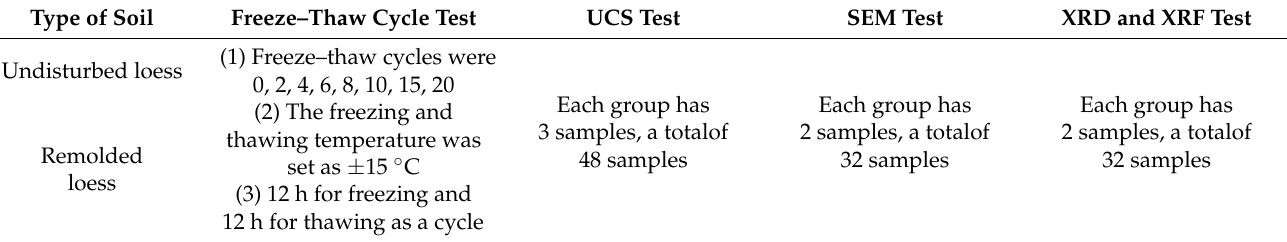
Table 1. Test list.